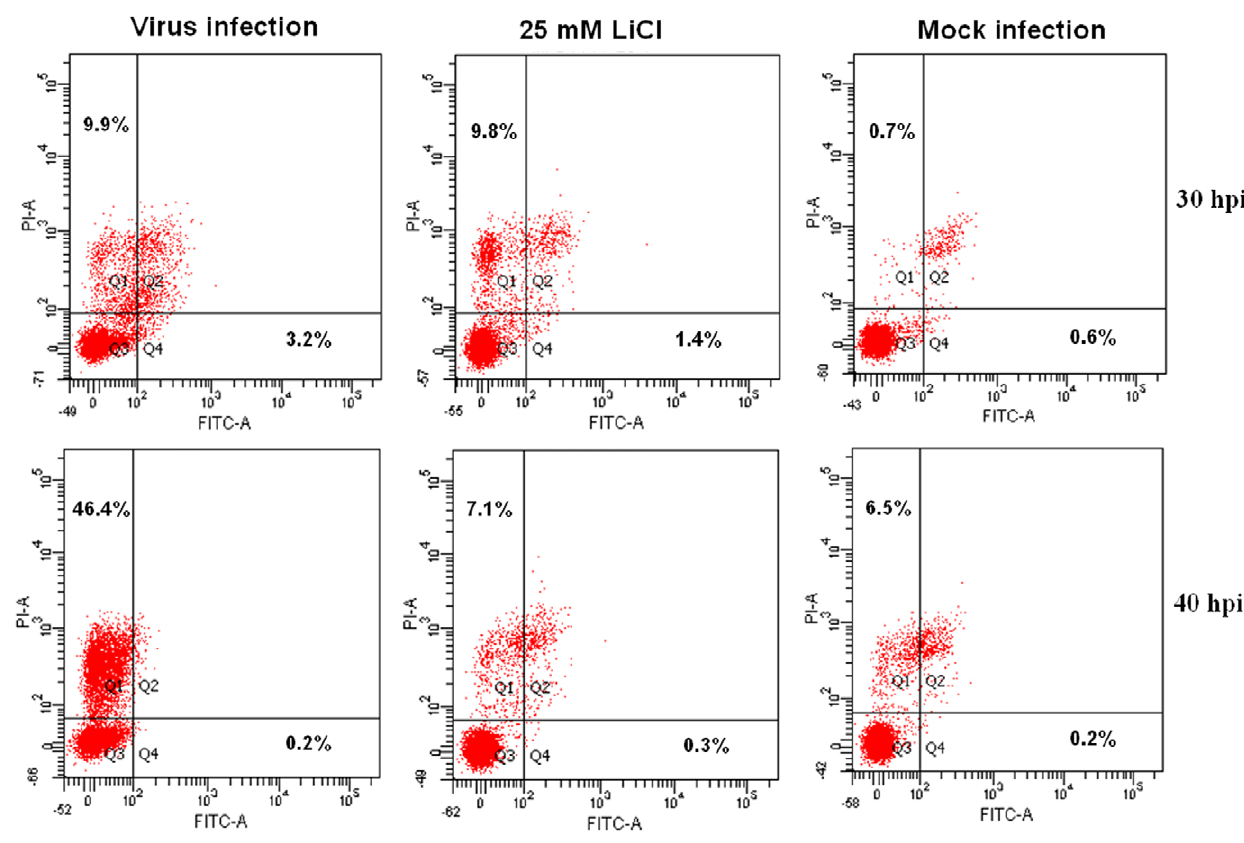
Figure 8. Cell apoptosis analysis by flow cytometry. The virus-infected cells were stained with Annexin V-FITC and PI, after they had been treated with 25 mM LiCl. The cell apoptosis was analyzed by flow cytometry at either 30 or 40 h.p.i. The early and late apoptosis was quantified and indicated in Q4 and Q1 gates, respectively. The apoptosis rates of cells are indicated.